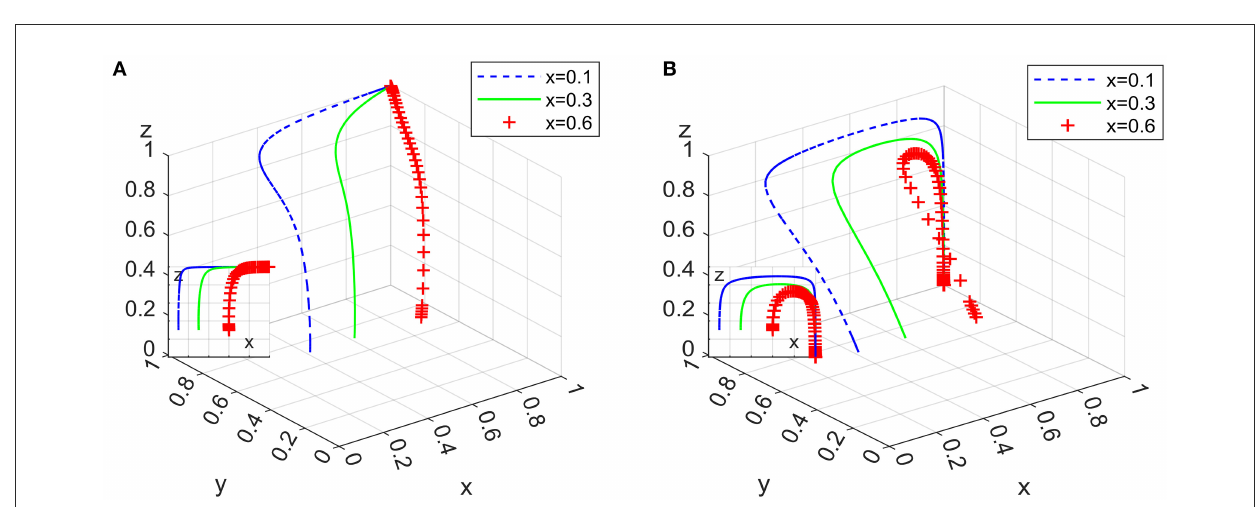
FIGURE6 Impact of clients’ strategies in system L (A) and system P (B)